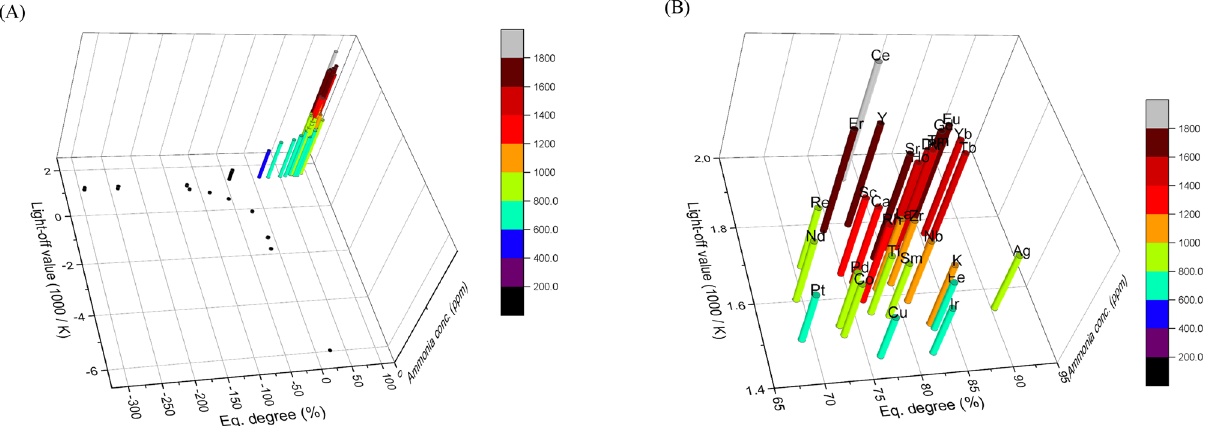
Figure 6. Correlation between Maximum ammonia concentration, equilibrium achievement degree and light-off value. ( A ) All catalysts. ( B ) Enlarged view of the crowded region in panel ( A ). The elemental symbols correspond to the added